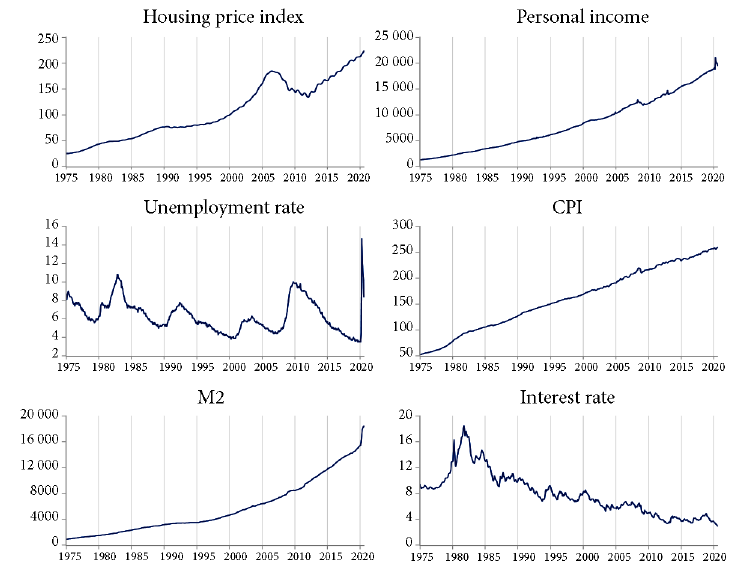
Figure 1. House prices and macroeconomic